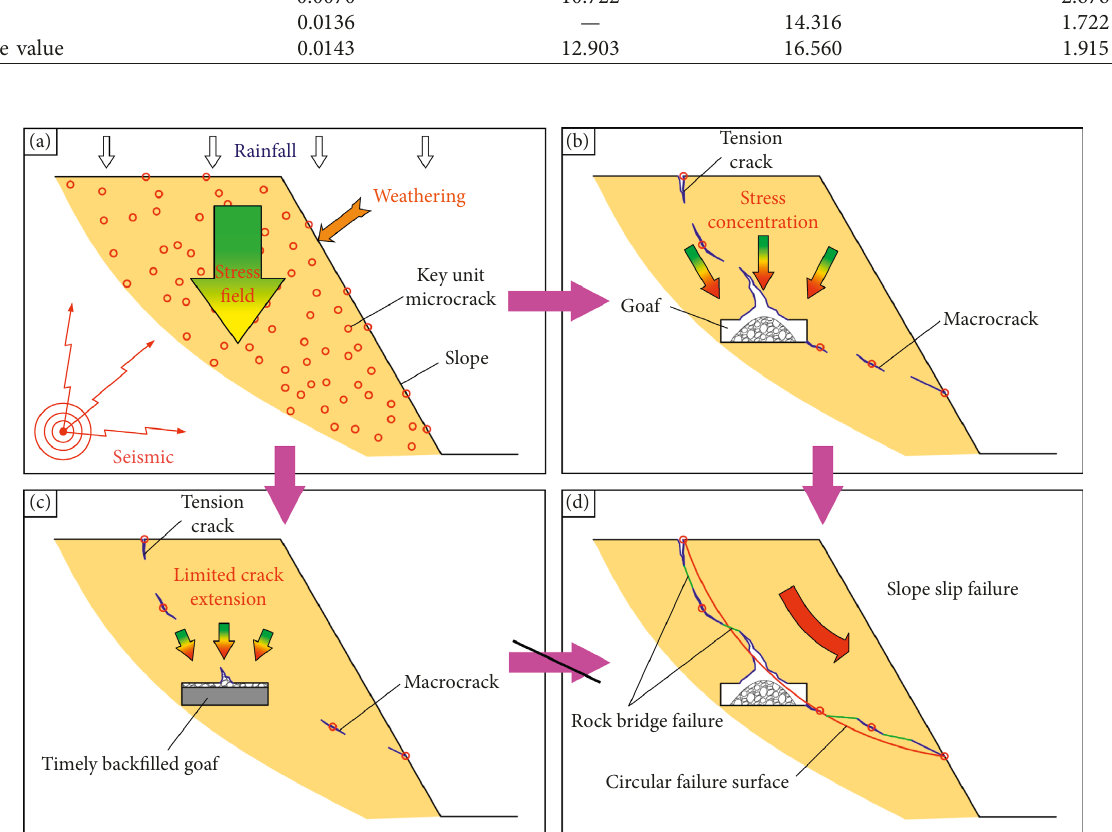
Figure 10: Failure mechanism of HSRS: (a) primary rock slope; (b) crack extension using open-stope mining method; (c) limited crack extension using backfill mining method; (d) circular failure